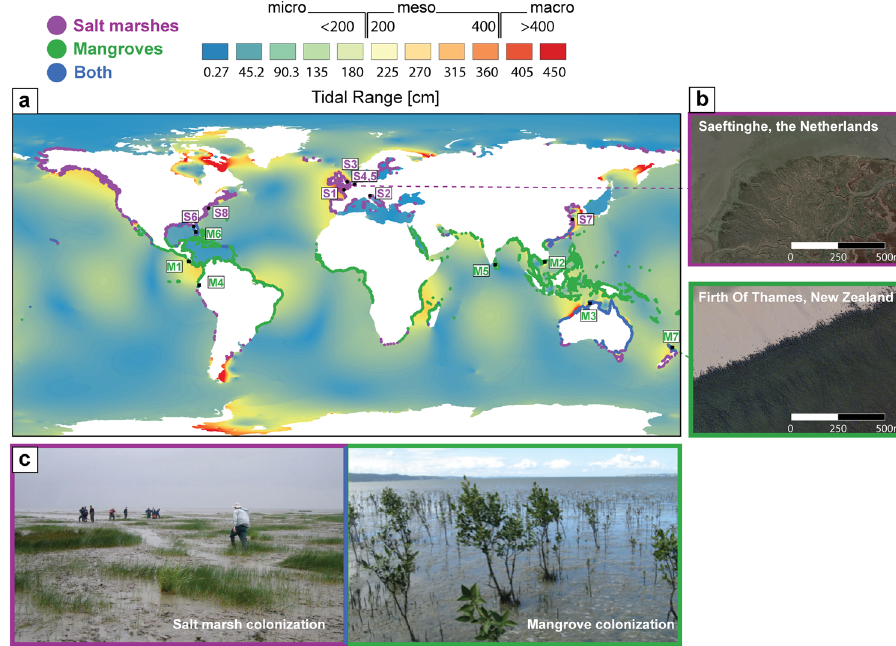
Fig. 1 Study sites. a Global distribution of salt marshes (purple), mangroves (green) and coexistence of both (blue) relative to the M2-tidal range 20,21 , S1- 8 and M1-7 are salt marsh and mangrove systems investigated in this study; b example of distinct channel networks in salt marsh and mangrove systems. c Snapshot of different colonization strategies between salt marsh and mangrove systems. Salt marshes colonize slowly (~years 76 ) creating a patchy spatial pattern, whereas mangroves colonize fast (~weeks 24 ) creating a homogenous spatial